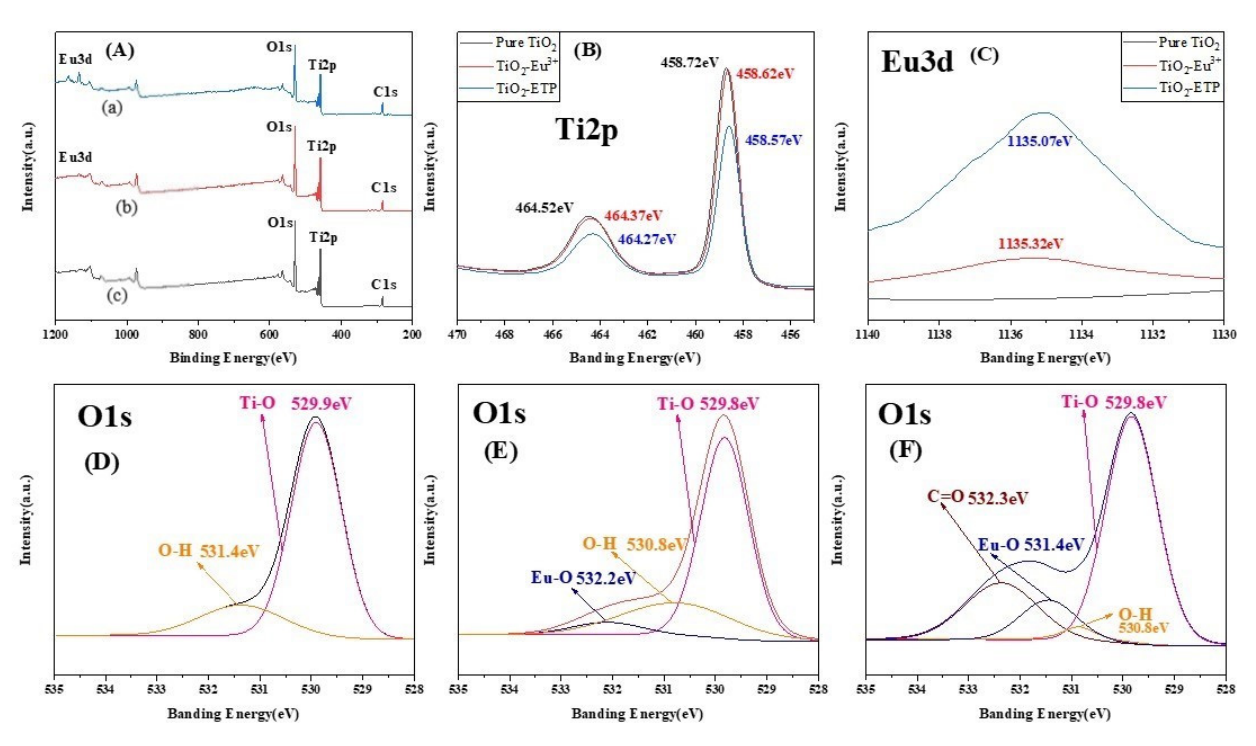
Figure 6. ( A ) Survey XPS spectra, ( B ) XPS spectra of Ti2p, ( C ) XPS spectra of Eu3d, ( D ) XPS spectra of O1s in TiO 2 , ( E ) XPS spectra of O1s in TiO 2 -Eu 3+ , ( F ) XPS spectra of O1s in TiO 2 -ETP.